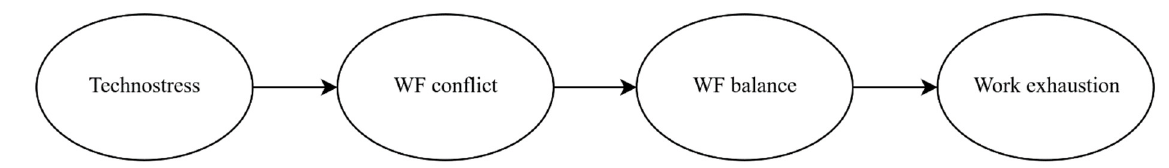
Figure 1. The research model. Note . Arrows refer to the hypothesized direct e ff ects.